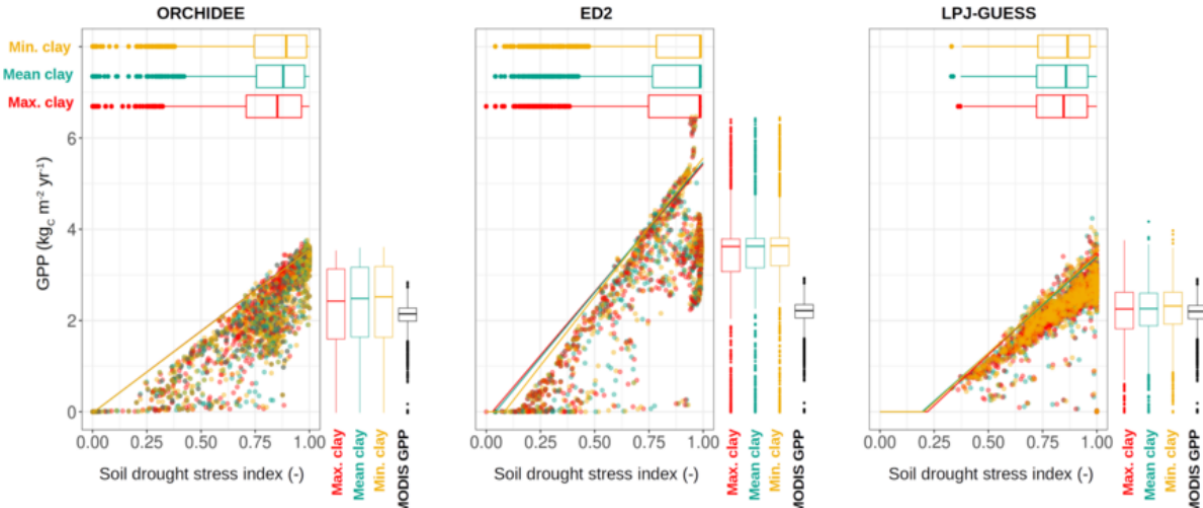
Figure 3. Ecosystem GPP as a function of the soil drought stress index (SDI) as predicted at the end of the historical period (2016) by each terrestrial biosphere model used in this study. The SDI values range between 0 and 1, with no stress represented by SDI = 1, full stress conditions represented by SDI = 0. The boxplots represent the distributions of the stress index for each scenario and the coloured lines are the 95% quantile regression per scenario (with the same colour legend). Each dot is a grid cell (1 ◦ resolution).